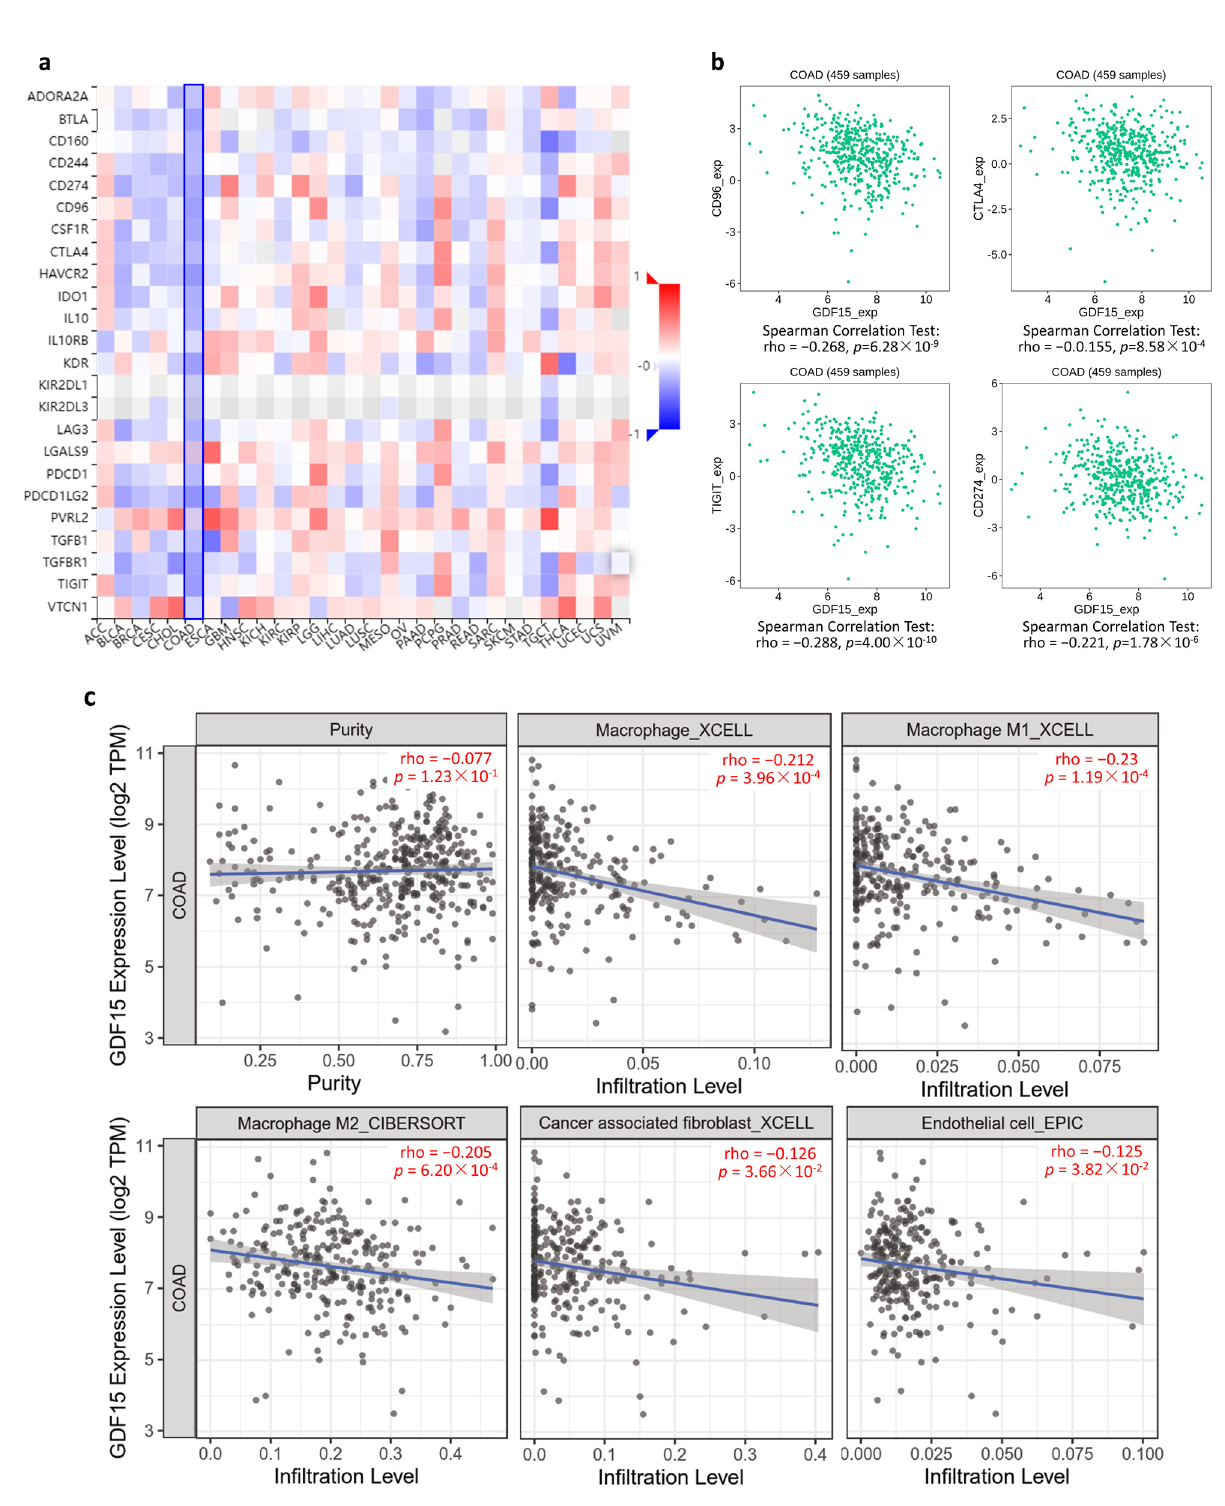
Figure 6. GDF15 negatively correlated with immunoinhibitory genes and immune infiltration of macrophage, cancer associated fibroblast, and endothelial cells. ( a ) Correlation analysis between the expression of GDF15 and 24 immunoinhibitory genes across human cancers based on TISIDB. ( b ) Spearman’s correlation between GDF15 and CD96, TIGIT, CTLA4, and CD274 (PD-L1). ( c ) TIMER analysis of the purity-corrected Spearman’s correlation between the expression of GDF15 and five immune cells in COAD.